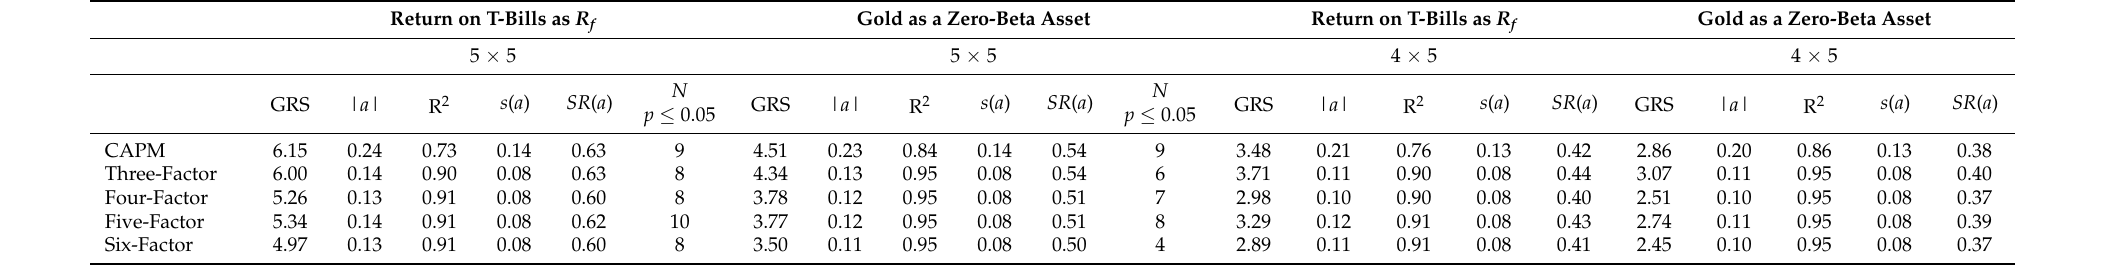
Table 9. Statistical summary of GRS tests to explain regressions of monthly excess returns over Treasury bills and gold return from January 1981 to December 2015. The regressions use the CAPM, three-factor, four-factor, five-factor, and six-factor models to explain excess returns on 25 size and book-to-market portfolios. The GRS statistic tests the null hypothesis that the alphas of all 25 portfolios are jointly equal to zero. | a | is the average absolute alpha for a set of regression on the portfolios with (5 × 5) and without microcaps (4 × 5); R 2 is the mean-adjusted R-squared; s ( a ) is the mean standard error of alphas; and SR ( a ) is the average Sharpe ratio of alphas. The critical values for the GRS statistic are 90%: 1.41; 95%: 1.56; 97.5%: 1.69; 99%: 1.86, and 99.9%: 2.25. Return on T-Bills as R